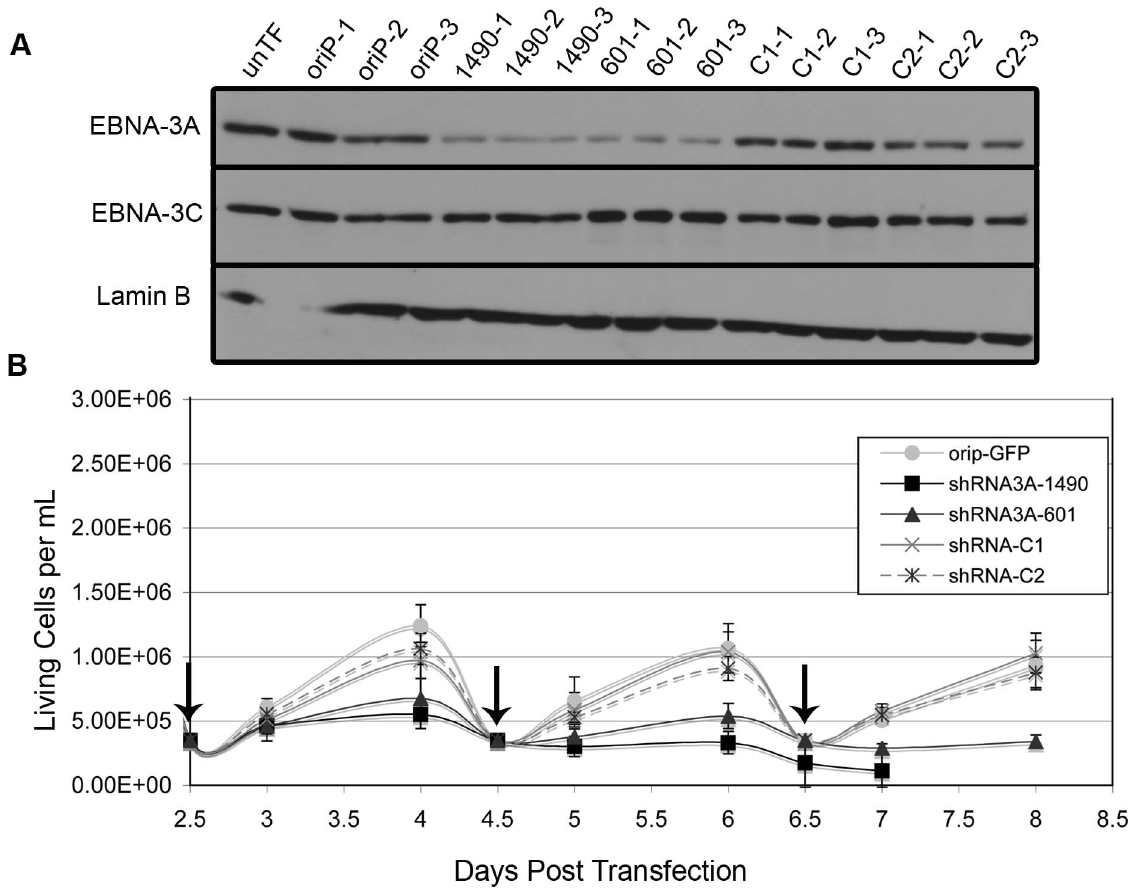
Figure 2. EBNA-3A is essential for proliferation of the Wp-R BL cell line Sal. Sal BL cells were transfected with empty vector ( oriP -GFP), oriP - GFP encoding non-EBNA-3A-targeting control shRNA (C1 and C2), or two different EBNA-3A-specific shRNAs (1490 and 601). (A) EBNA-3A and EBNA- 3C expression at 4 days post-transfection was monitored by immunoblotting; Lamin B served as a loading control. Untransfected cell lysate was also analyzed (unTF). (B) The average number of live cells per mL was analyzed beginning two days post-transfection. Cells were counted daily and reseeded every two days (as indicated by vertical arrows). Results shown are an average of two independent experiments performed in triplicate. Knockdown of EBNA-3A resulted in statistically significant effects on cell growth (shRNA3A-1490 p , 0.001; shRNA3A-601 p=0.005, both compared to the average of three control groups). In one experiment, shRNA3A-1490-containing cells could only be maintained for 7 days, resulting in data from only a single experiment performed in triplicate for the 8-day data